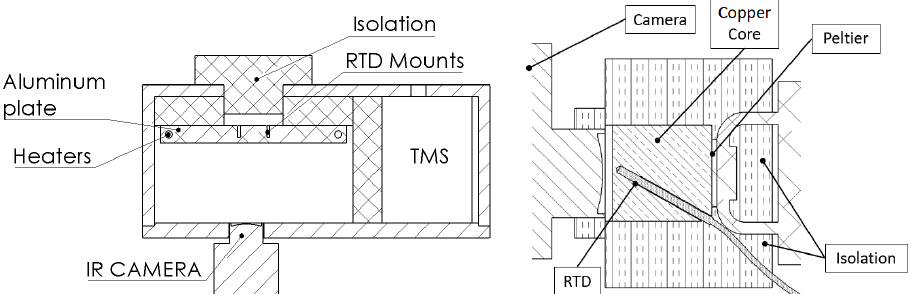
Figure 5. Main IR camera calibrator to the left and secondary calibrator to the